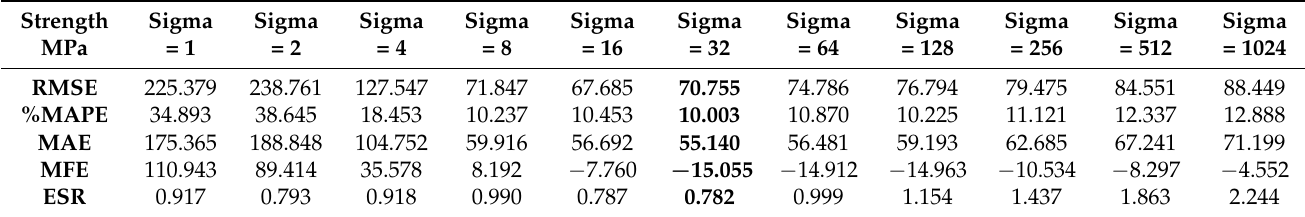
Table 5. SVMs training errors for two input results with fixed gamma =